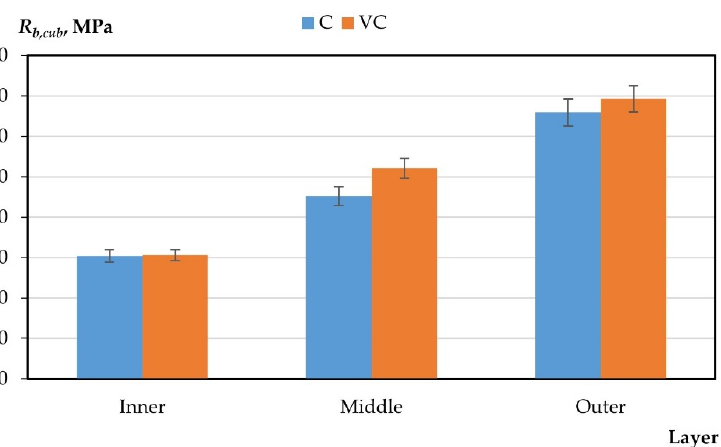
Figure 4. Change in compressive strength by layers (C—centrifuged concrete, VC—vibrocentrifuged concrete).